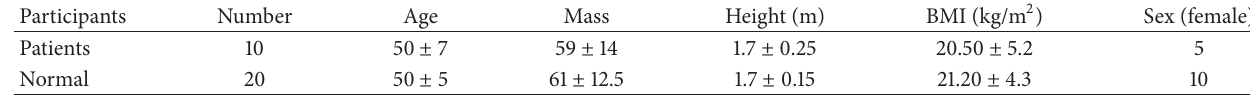
Table 1: The characteristics (mean ± SD) of the subjects that participated in this study.